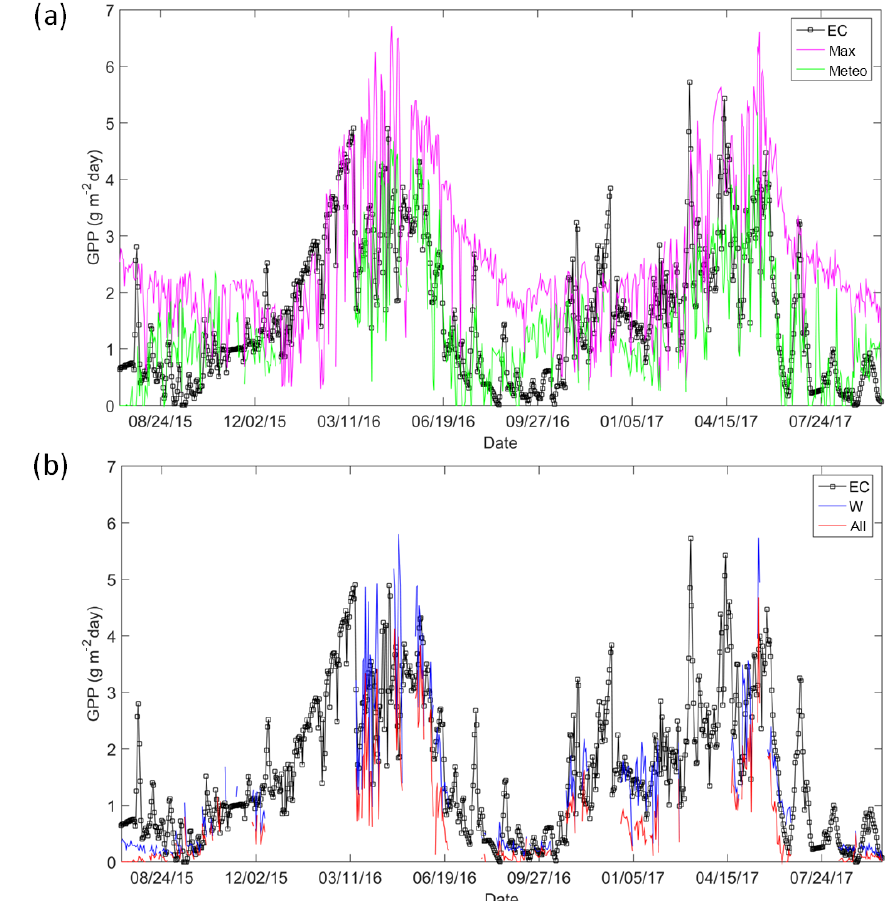
Figure 3. Temporal profile of the GPP fluxes: (a) EC, max and meteo (b) EC, W and all